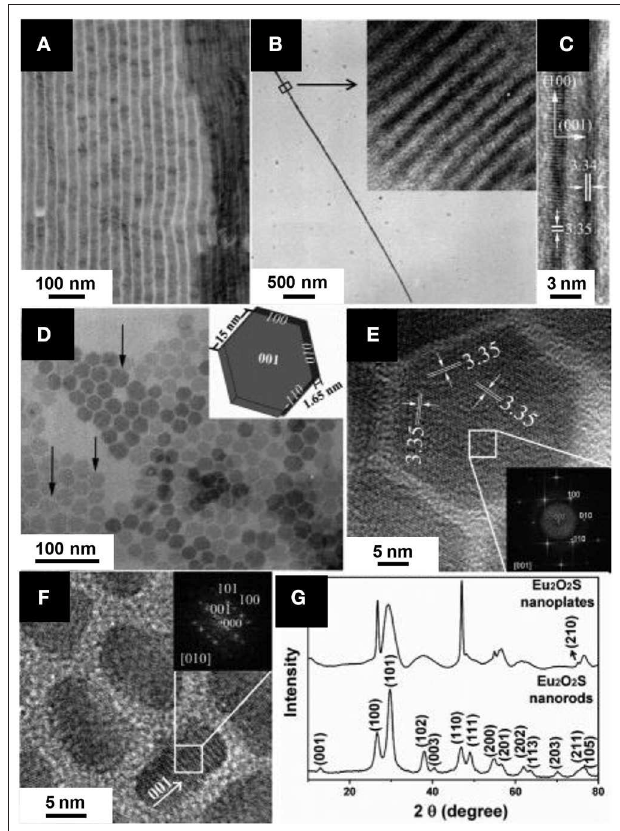
FIGURE 14 | Characterization of Eu 2 O 2 S nanoparticles obtained by decomposition of [Eu(phen)(ddtc) 3 ] by Zhao et al. (2006a) TEM micrographs of self-assemblies formed by the hexagonal nanoplates (A) , of a single nanowire (B) with a zoom in inset and HRTEM micrograph of two nanowires (C) . (D) TEM micrographs of hexagonal nanoplates lying on their flat surface. Inset: representation of a single nanoplate. HRTEM images of Eu 2 O 2 S nanoplates lying on their flat surface (E) and of short nanorods (F) . Insets are FFT of the indicated regions. (G) Powder XRD pattern of the Eu 2 O 2 S nanoparticles. Adapted with permission from Zhao et al. (2006a), copyright (2006) American Chemical